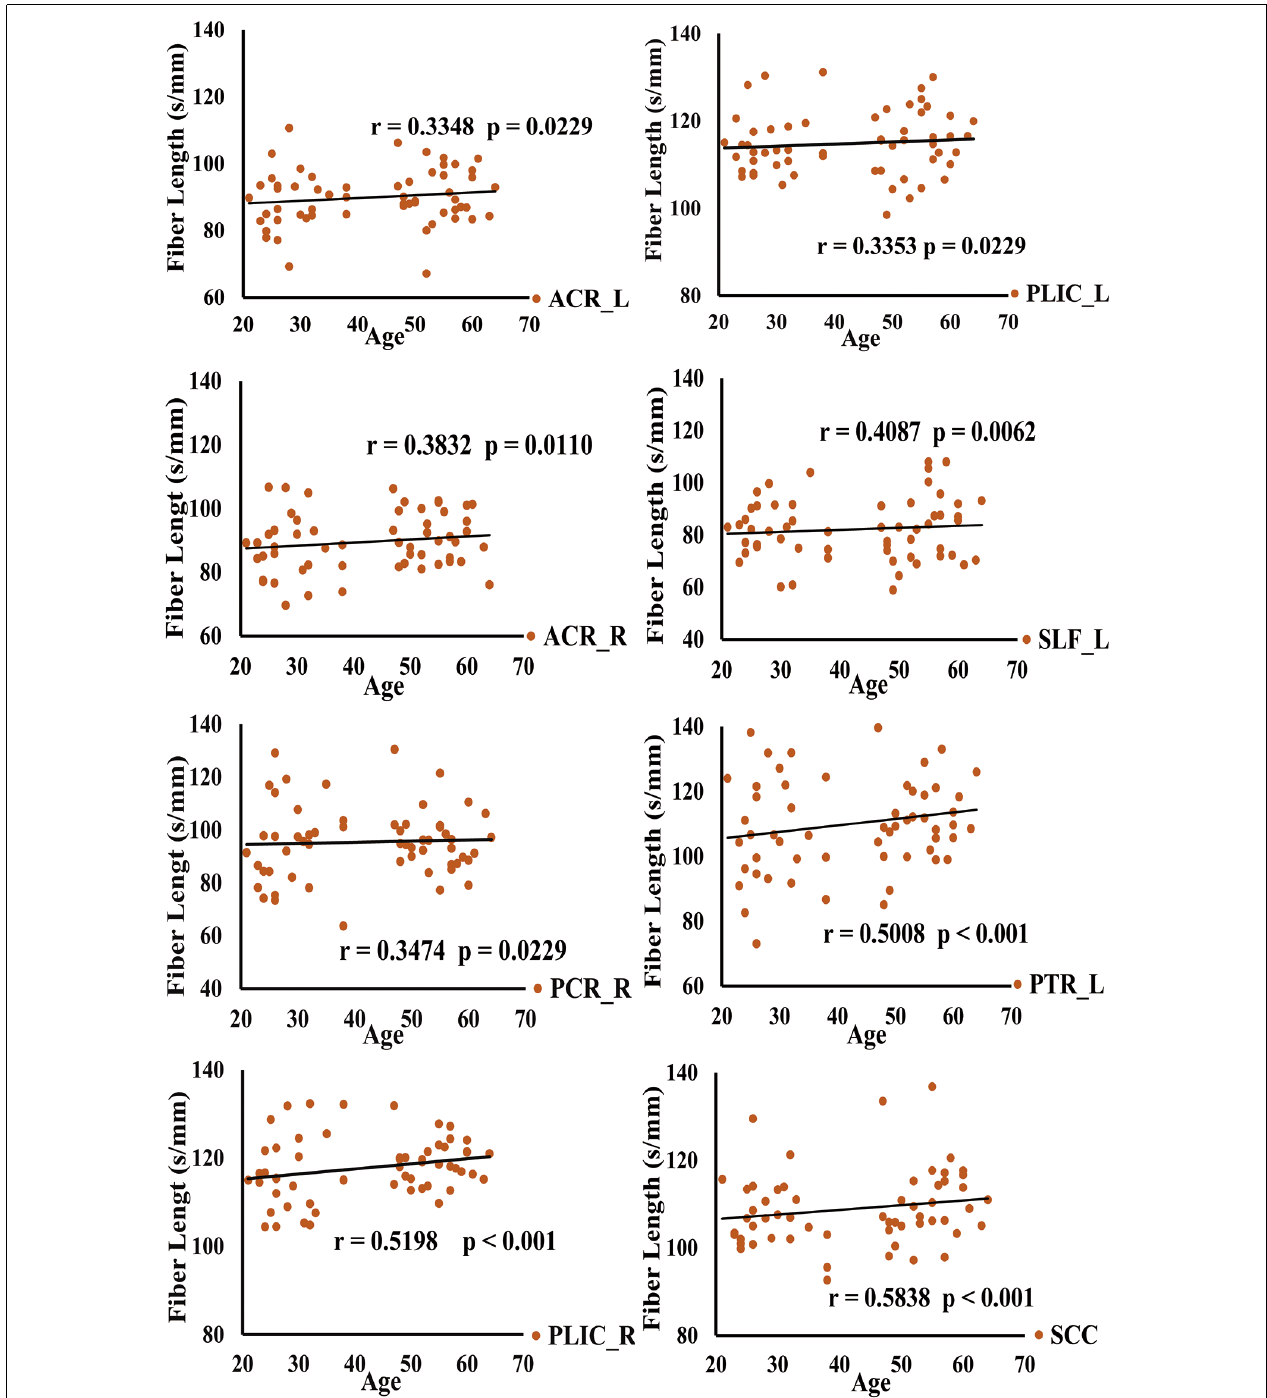
FIGURE 3 | Spearman correlation analysis of the relationship between fiber length and age is shown in this figure.